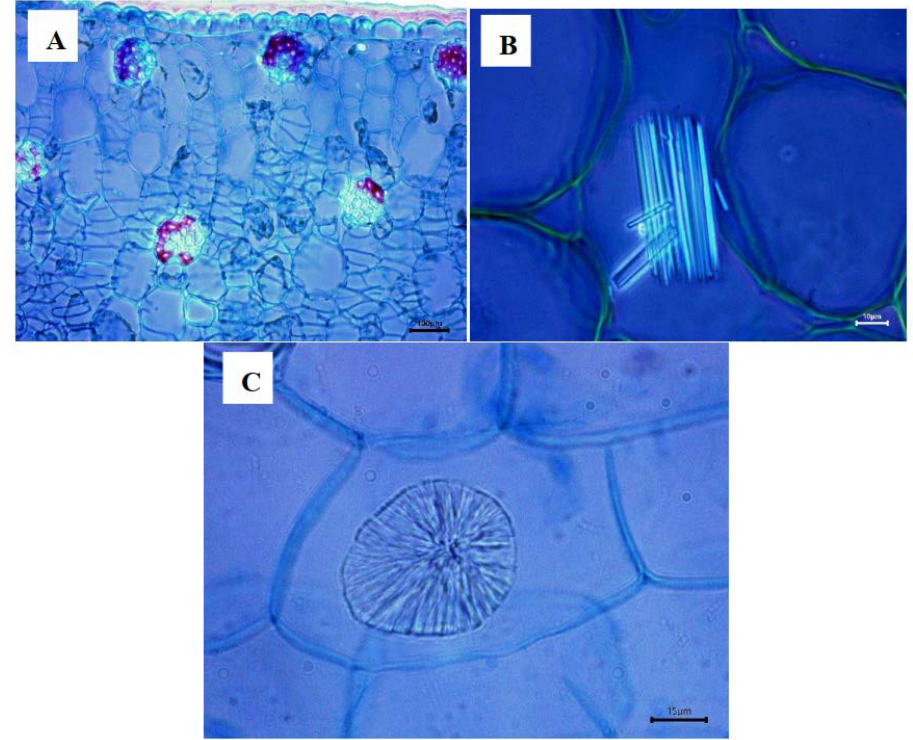
Figure 9. Presence of secondary thickenings and calcium oxalate crystals in the mesophyll. ( A ) Laelia aurea (cells with secondary thickening). ( B ) Laelia superbiens , crystals in the shape of raphides present in the mesophyll. ( C ) Laelia rubescens, druse crystals in the